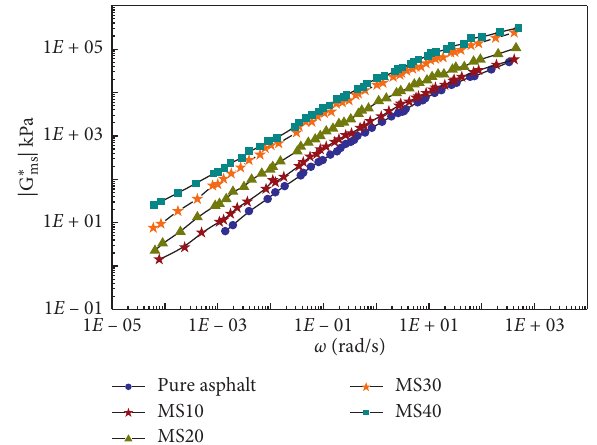
Figure 5: Master curves of the dynamic shear modulus of asphalt mastic.